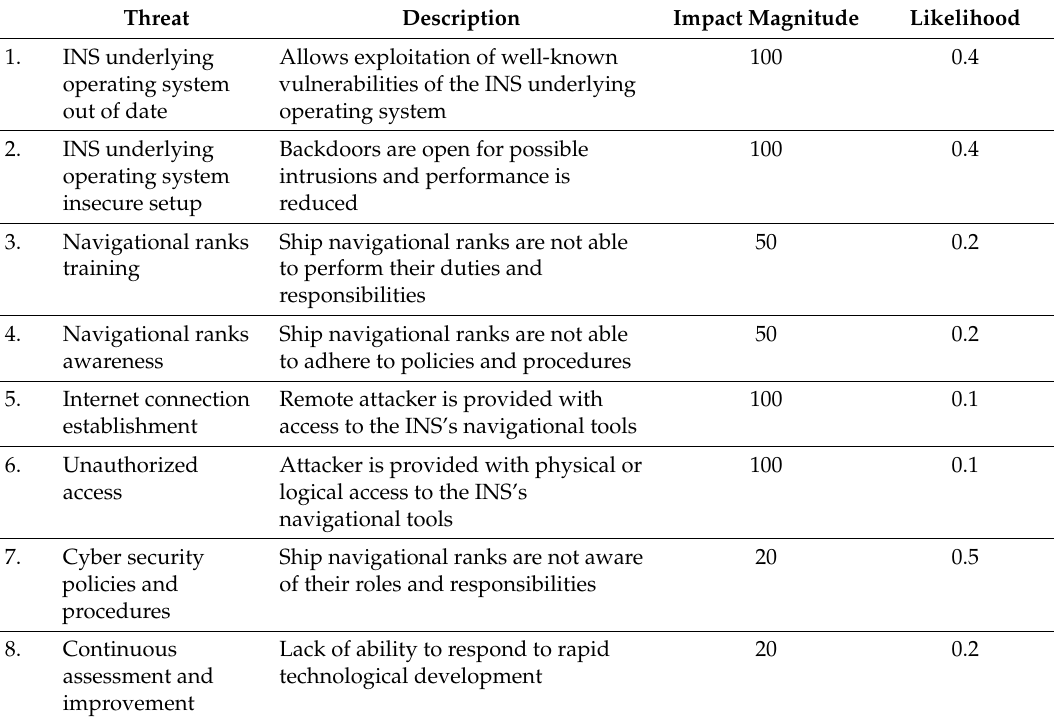
Table 4. The identified INS cyber